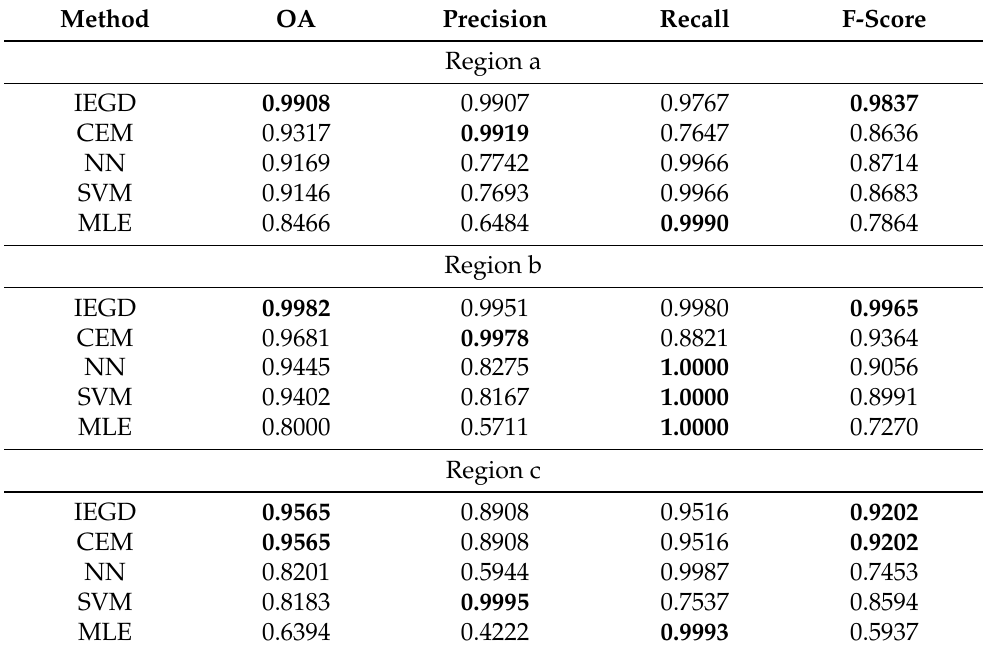
Table 3. The accuracy evaluation index of the use of various methods in different regions, where OA denotes the ratio of the predicted correct result samples to the total samples, precision denotes the ratio of actual positive samples to predicted positive samples, recall denotes the ratio of the predicted positive samples to the actual positive samples, and the F-score is a combined consideration of the precision and